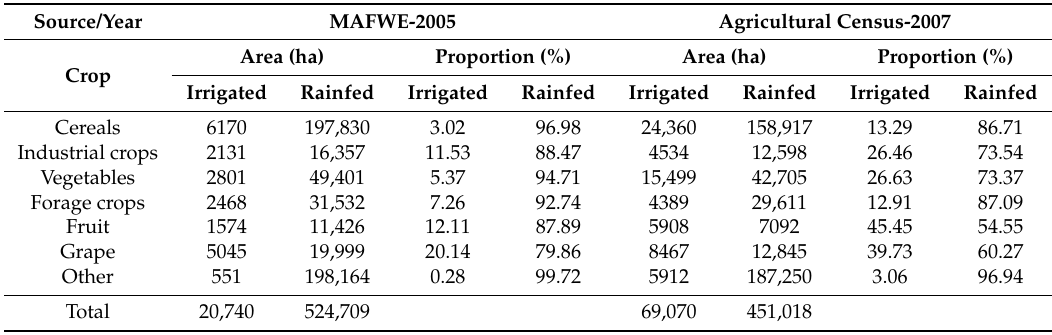
Table 4. Comparison of irrigated and rainfed agricultural cropping area in Macedonia according to two official